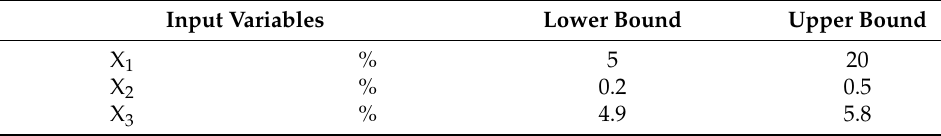
Table 7. Range constrains of input